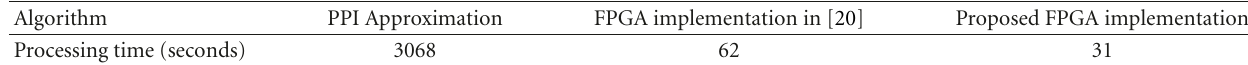
Table 4: Comparison of di ff erent implementations of the PPI